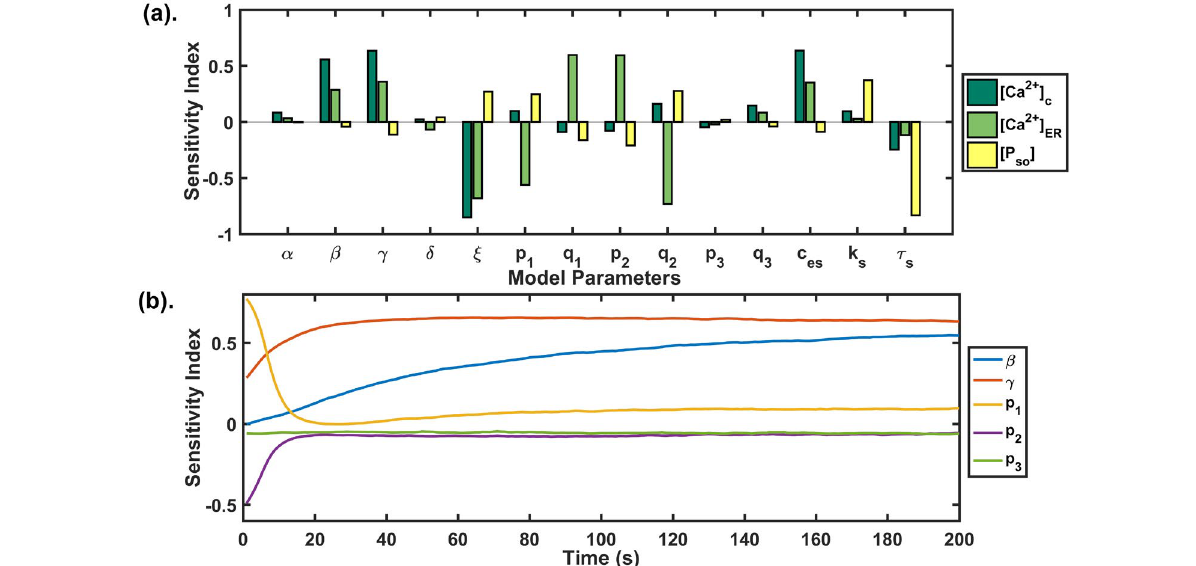
Figure 5. (a) GSA: the PRCC index plotted at t = 200 s shows the sensitivity of each model parameter against the state variables of our model. The higher the bar length, the more sensitive is the parameter to that variable. The parameter correlated negatively as well as positively with the model state variables; (b) temporal sensitivity analysis: the figure shows the temporal sensitivity analysis of parameters associated with calcium channels and pumps whose activities or expressions are significantly increased during Doxo treatment